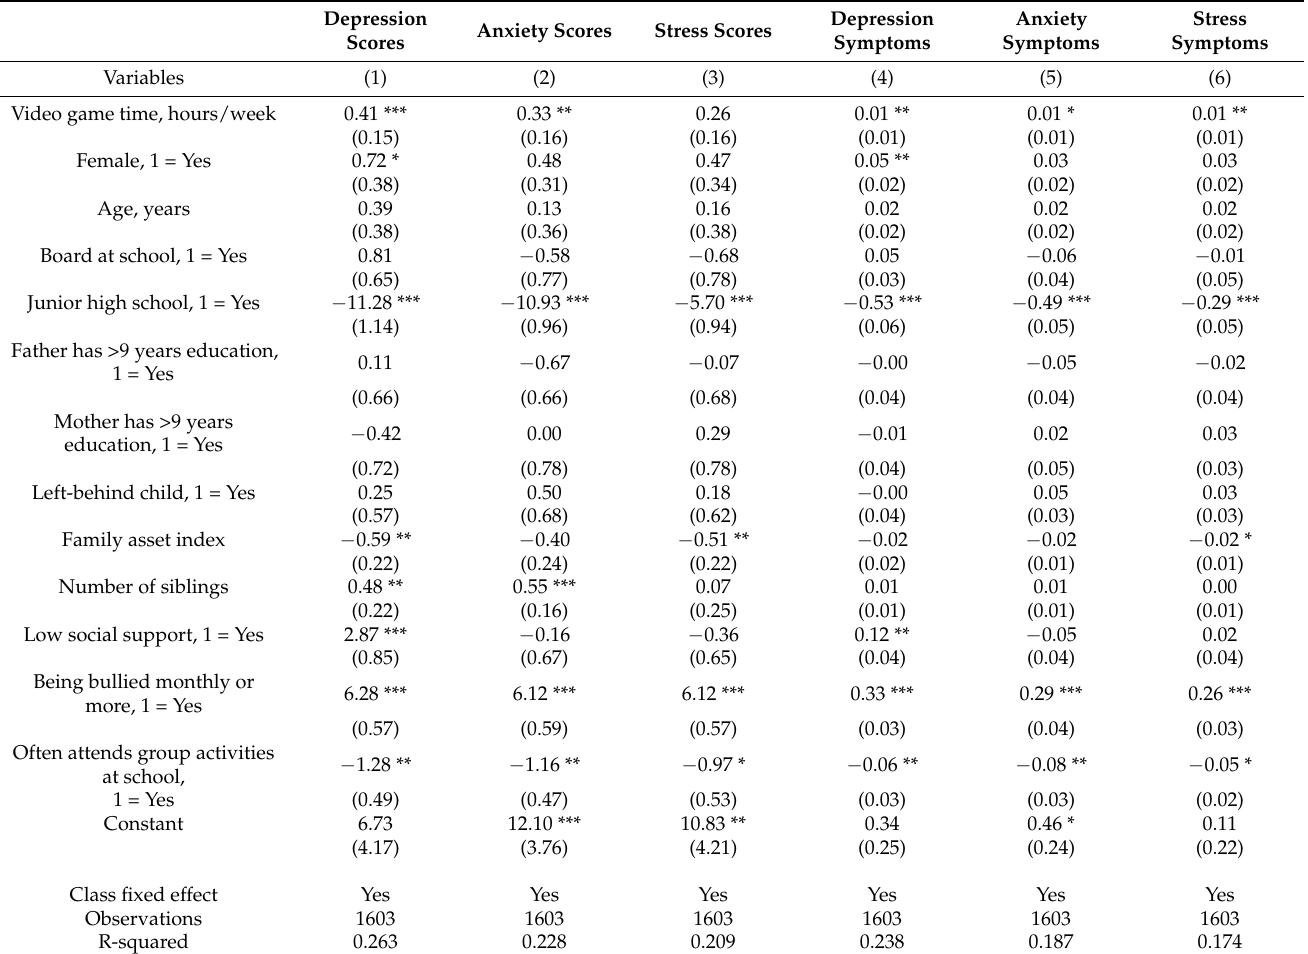
Anxiety Scores Stress Scores